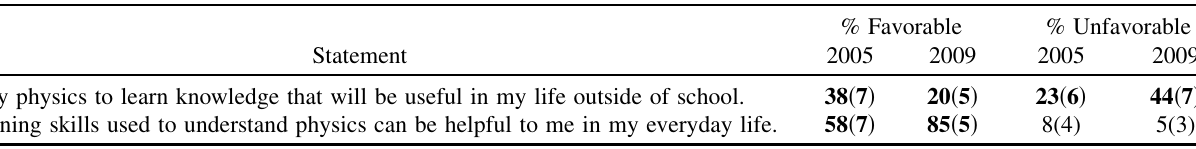
TABLE VIII. Responses of the retest participants to CLASS statements 14 and 30 as preinstruction freshmen (2005) and graduating seniors (2009). Significant shifts are in bold.